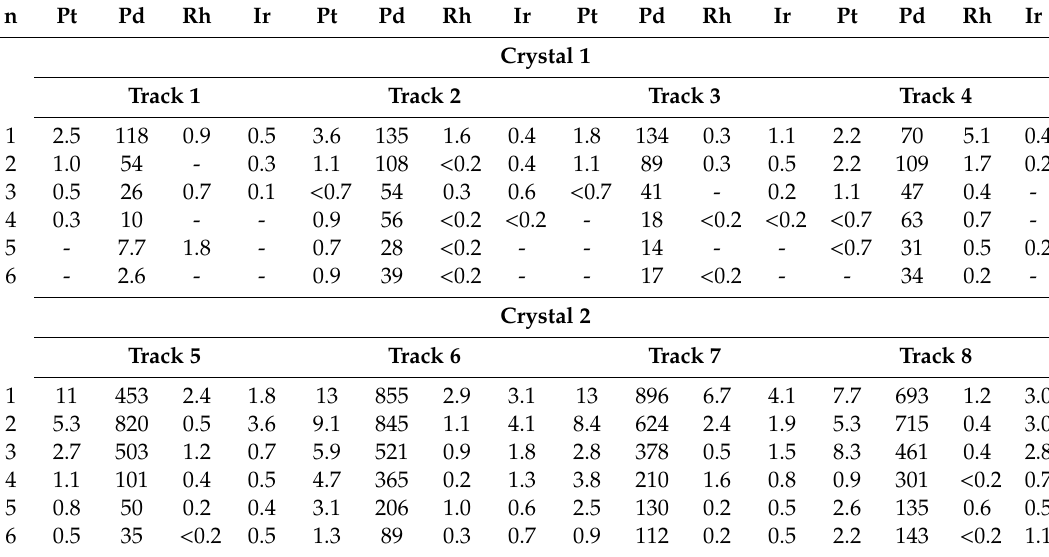
Table 13. Results of LA-ICP-MS analysis (in ppm) of the surface of pyrite crystals (1 and 2) for Pt, Pd, Rh and Ir (sample UV-3 / 13) (the Natalkinskoe